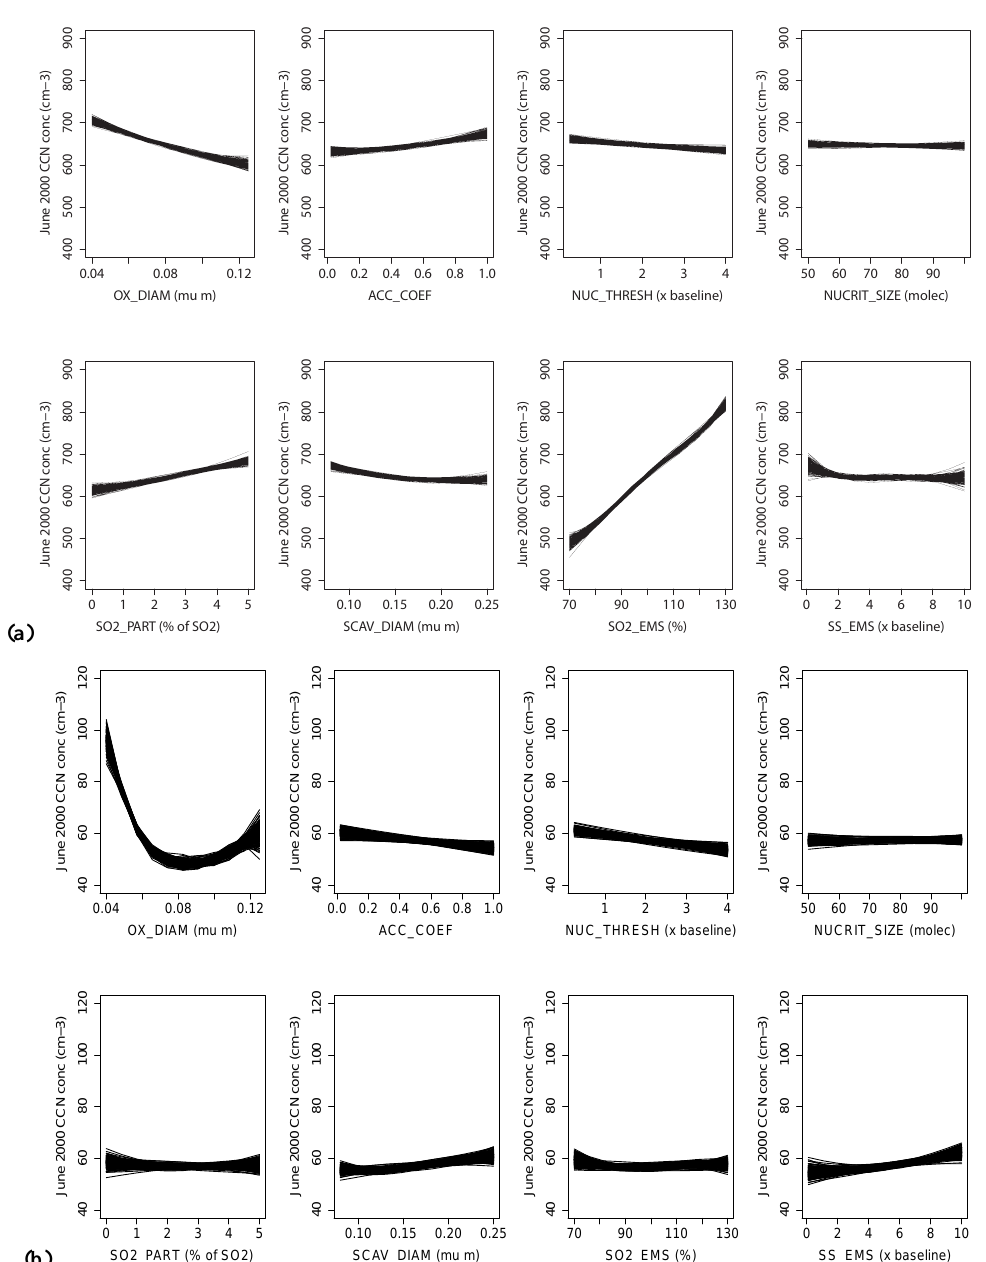
Fig. 8. The relationship between the CCN concentration and each of the parameters listed in Sect. 3 for (a) London grid cell and (b) Pacific grid cell. In each case the thickness of the line represents the emulator uncertainty whilst the spread on the y axis represents the uncertainty due to the uncertainty in the parameter. Each plot here is based on all other parameters being fixed. It is shown that uncertainty in sulphur emissions dominates uncertainty in CCN.